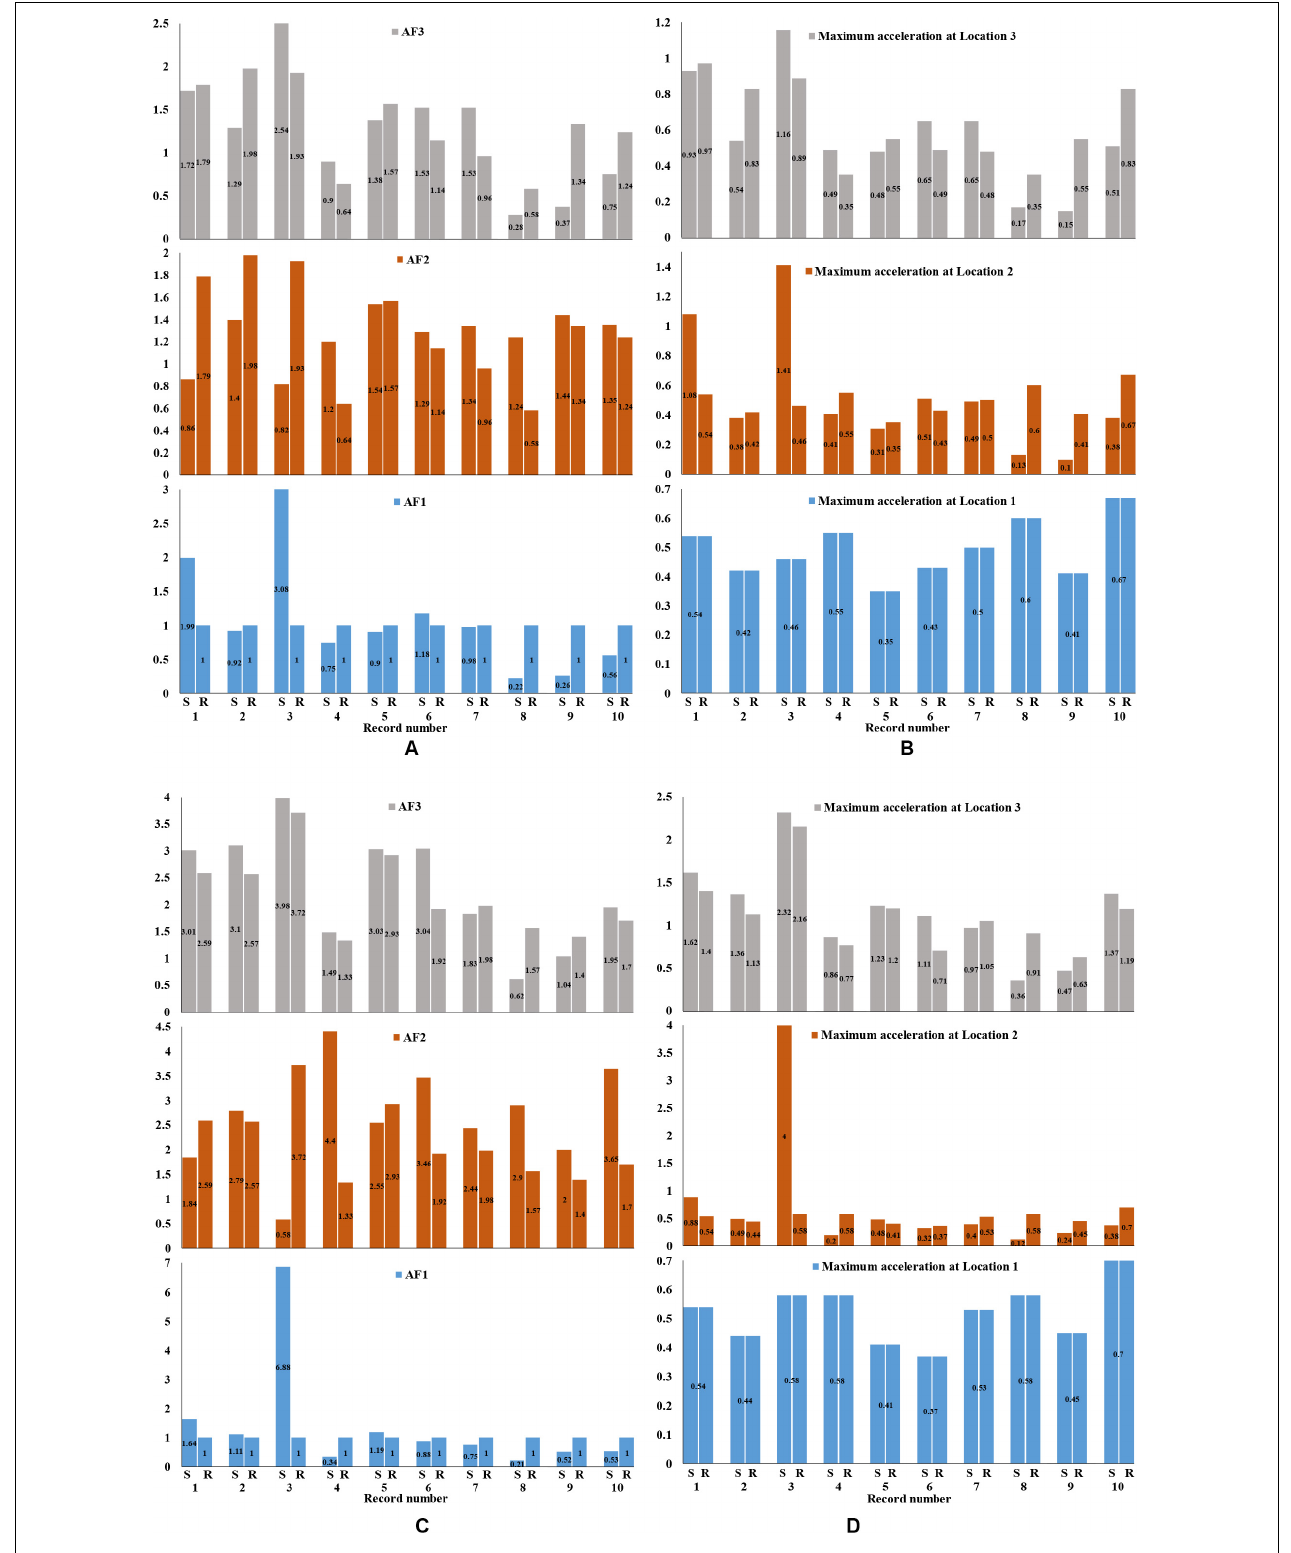
FIGURE 8 | Comparison of the amplification factors (A) and maximum accelerations (B) for the squat and amplification factors (C) and maximum accelerations (D) for the slender tank, for foundation on soft soil (S) and rock (R) for the unanchored cases (with friction coefficient µ 1 = 0.4).